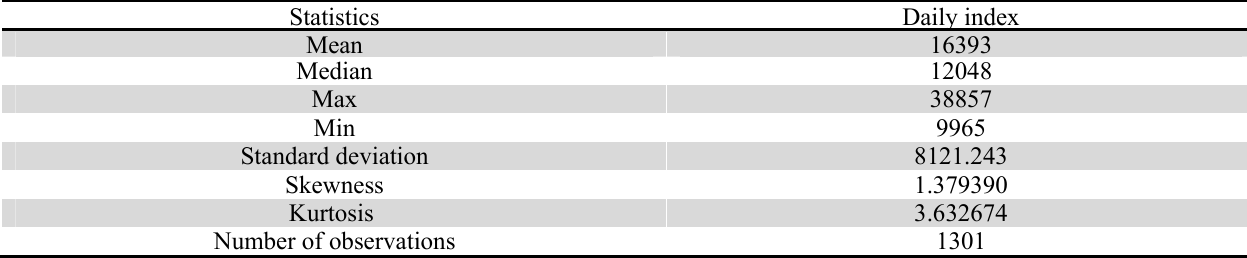
The summary of some basic statistics on currency